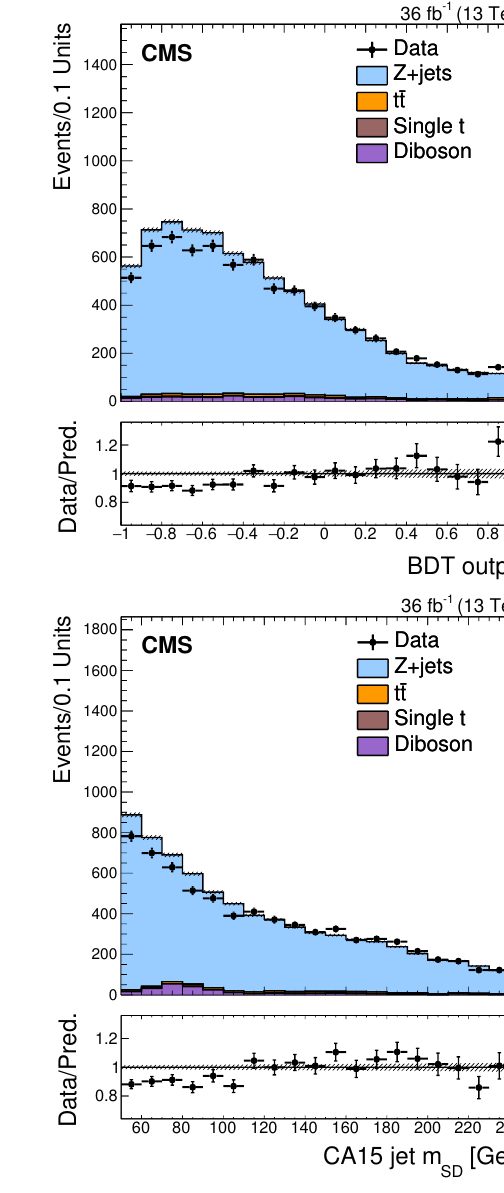
Figure 3 . Comparison of the BDT response (upper) and m SD (lower) in data and in simulation, in samples enriched in top-quark jets (left) and q/g jets (right). The lower panel of each plot shows the ratio of the observed data to the SM prediction in each bin. The shaded bands represent the statistical uncertainties in the